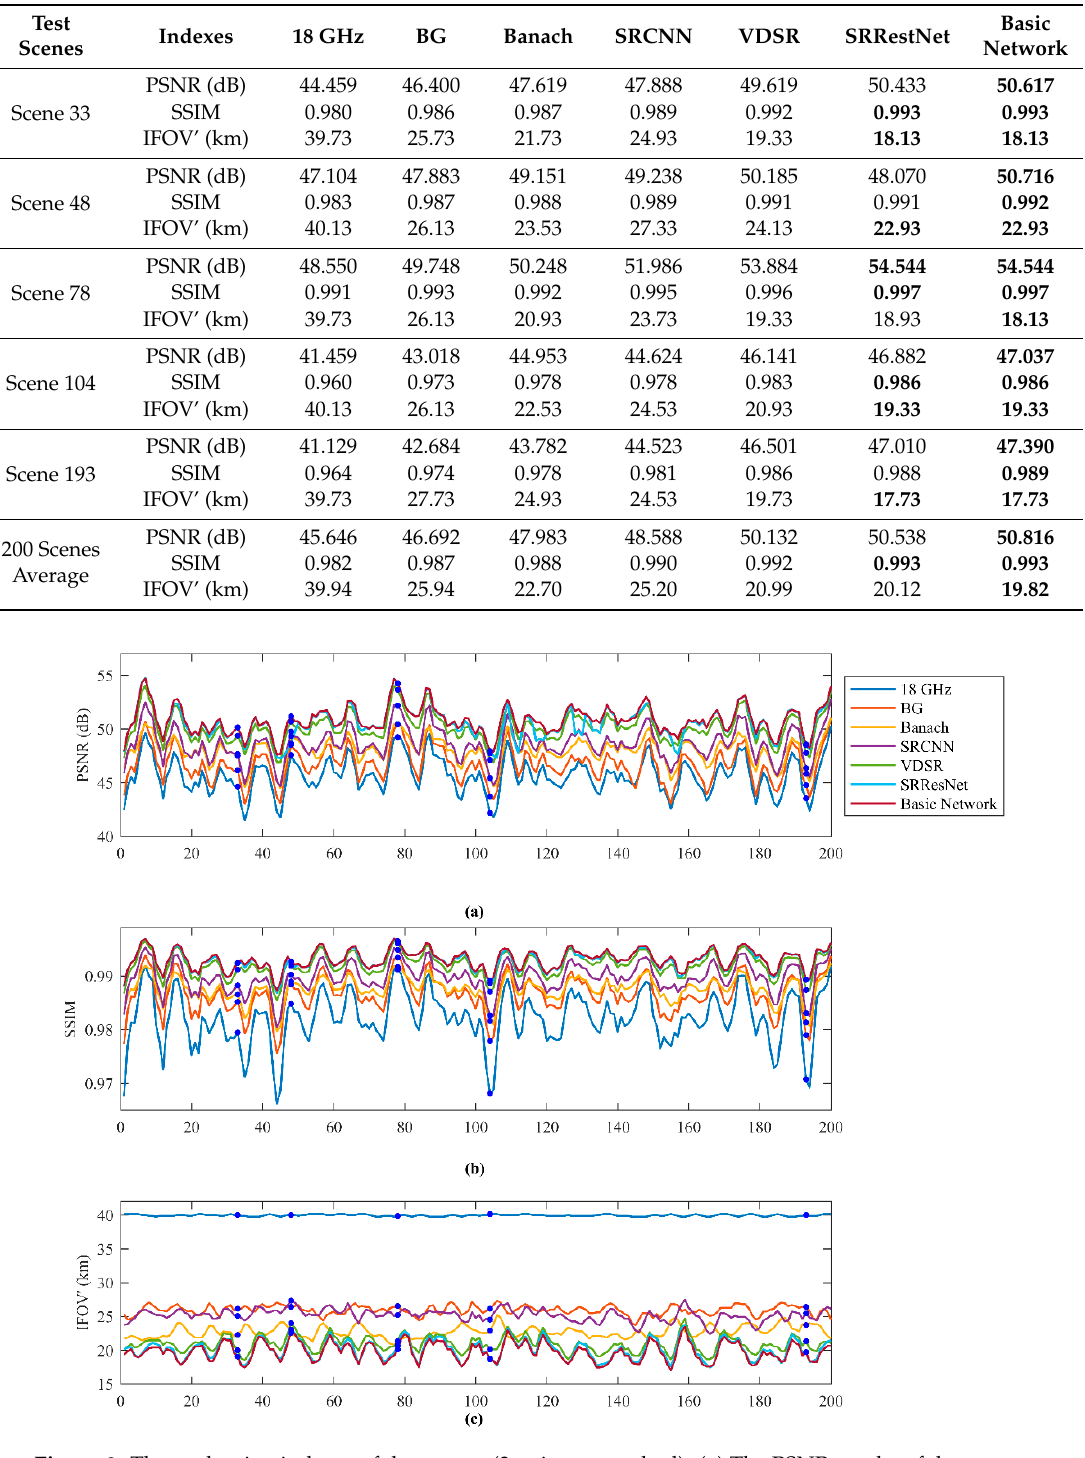
Figure 9. The evaluation indexes of the test set (3 points smoothed). (a) The PSNR results of the test set; (b) The SSIM results of the test set; (c) The IFOV’ results of the test set.